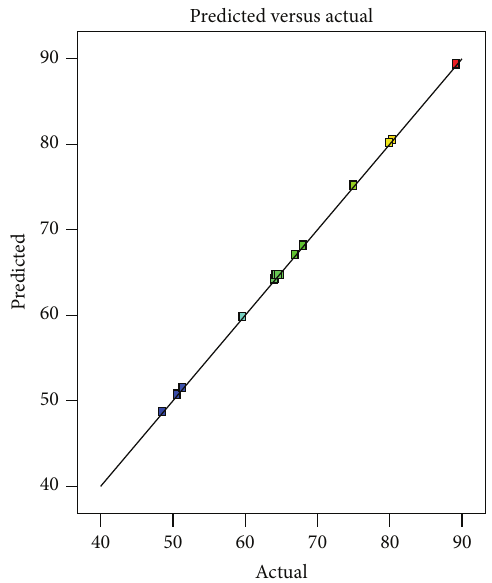
Figure 1: Comparison of predicted and actual values of the